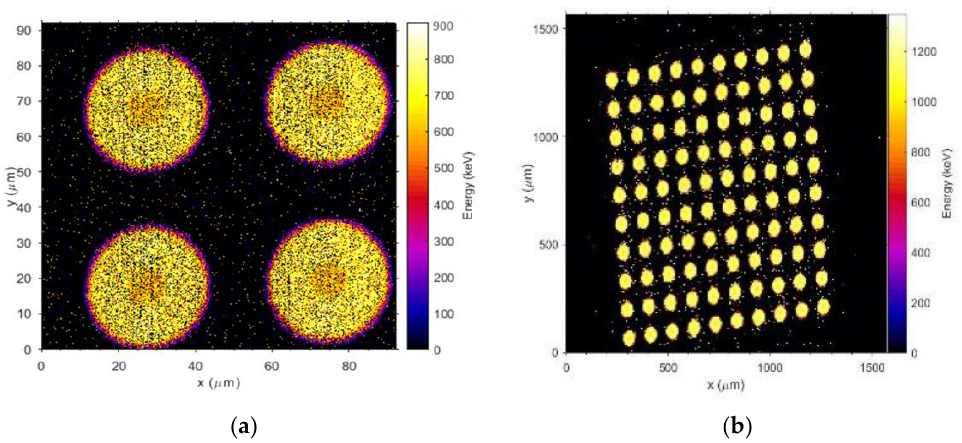
Figure 10. Response of the array of the trenched planar Mushroom microdosimeter to a He 2+ ion microbeam: ( a ) Median energy map of four SVs (5 µm thick) in response to a 3 MeV He 2+ ion microbeam and ( b ) full array (10 µm thick) in response to a 5.5 MeV He 2+ ion microbeam at a 10 V bias [22].